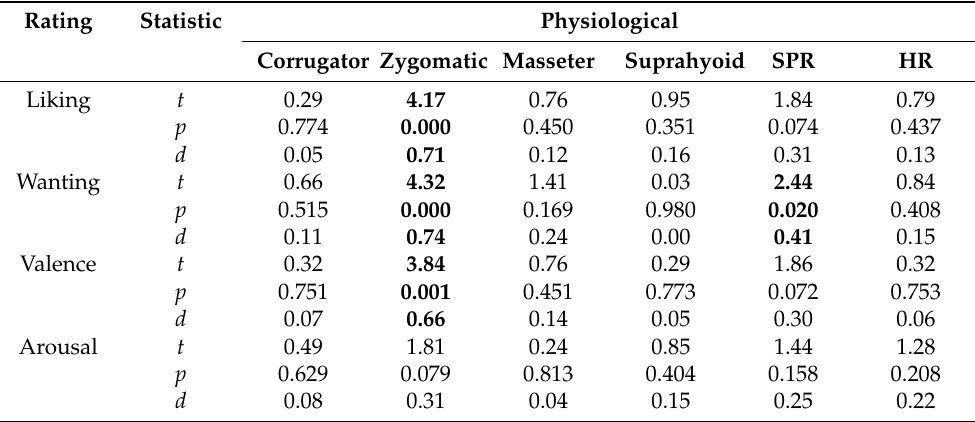
Figure 2. Mean (with standard error) intra-individual correlation coefficients ( r ) between subjective hedonic ratings and physiological activity while viewing food images. Corrugator = corrugator supercilii; Zygomatic = zygomatic major; SPR = skin potential response; HR = heart rate. *** p < 0.001; * p < 0.05. Table 2. Results of one-sample t -tests (two-tailed; t -, p -, and Cohen’s d -values) for correlation coefficients between subjective hedonic ratings and physiological